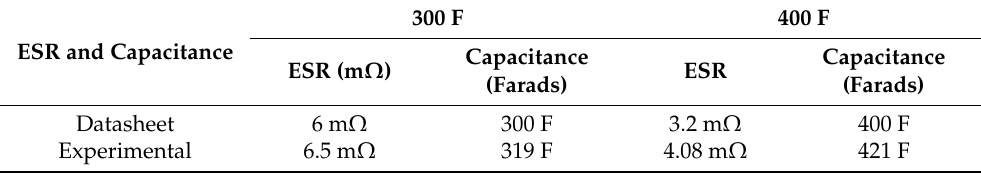
Table 5. ESR and capacitance. Table 5. ESR and